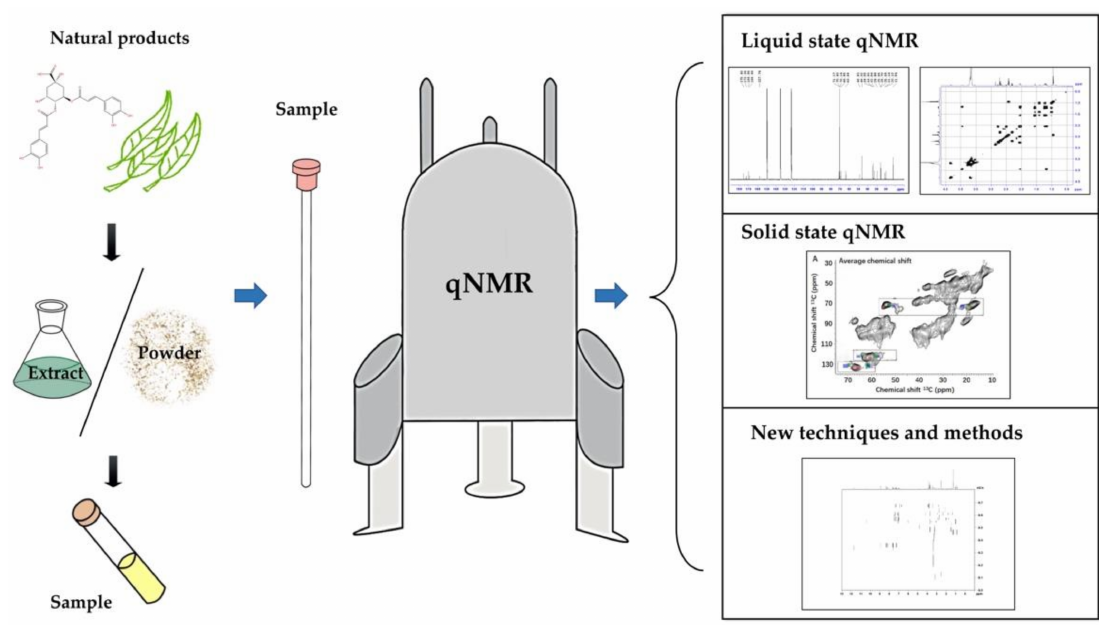
Figure 1. The graphical